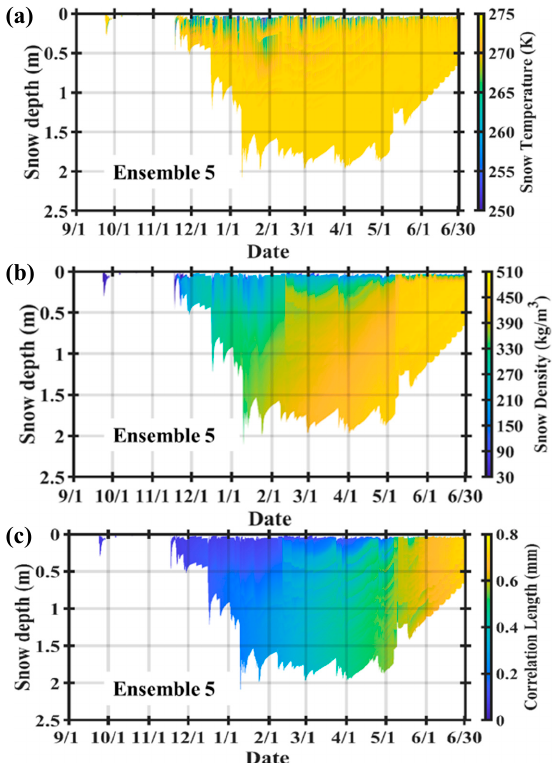
Figure 8. Ensemble 5 predictions of the seasonal evolution of vertical snowpack profiles contoured by ( a ) temperature, ( b ) density, and ( c ) snow correlation length from 9/1/2016 through 6/30/2017.